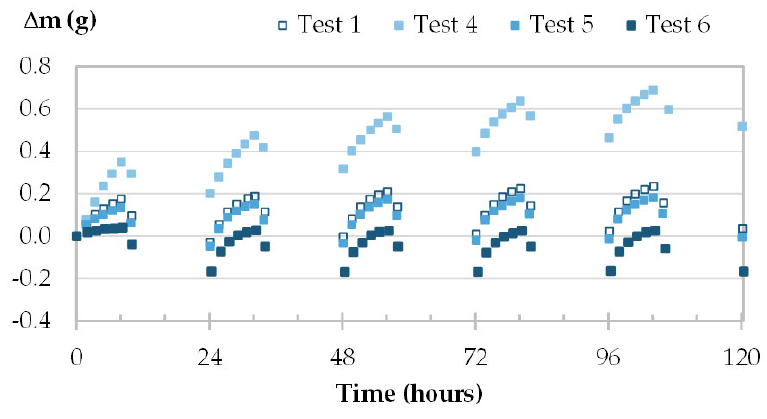
Figure 13. Moisture uptake and release for one specimen of GY (GY-c-3) at different initial conditioning. The initial water content impacts the trend of mass beam. For specimens having low initial water content (test 4—stabilized at 33%RH), the kinetics of all materials show an increasing tendency. The materials absorb more moisture than they release up to reach steady cycles. This induces the increase in water content during MBV test (Table 9).